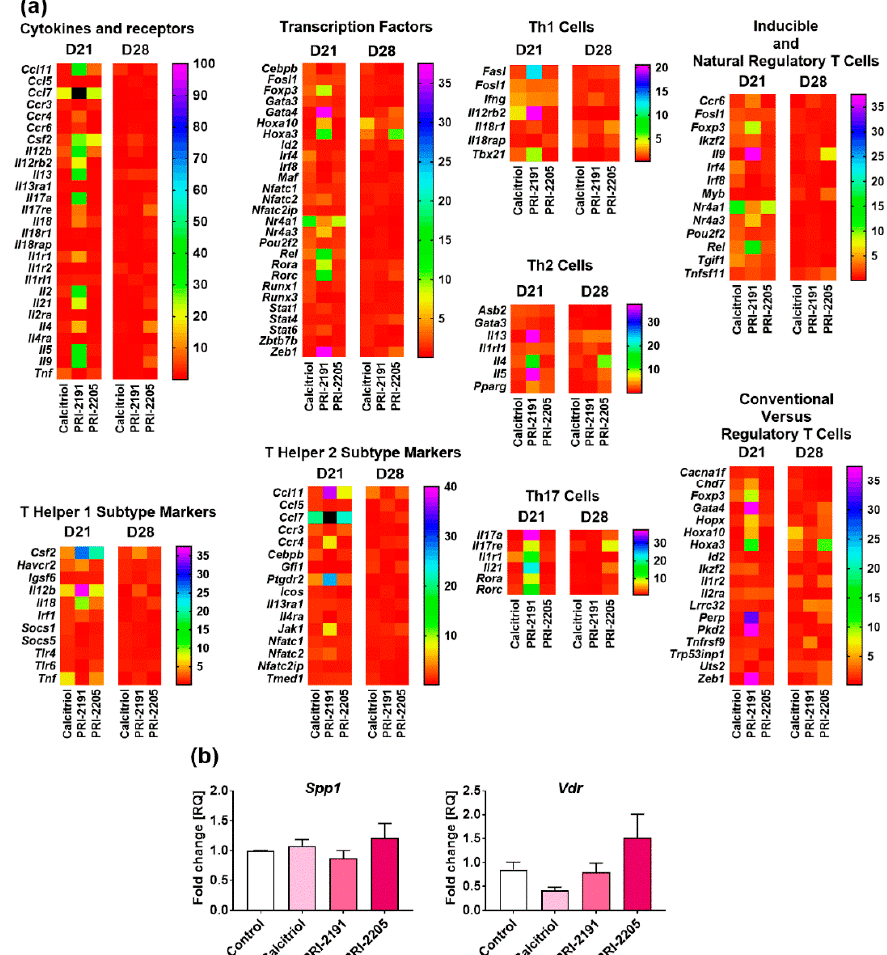
Figure 2. The gene expression profile in isolated mononuclear splenocytes from 4T1 tumor-bearing mice treated with calcitriol and its analogs. ( a ) Heat maps presenting mean relative quantification (RQ) values from duplicates. The genes were grouped according to the analysis provided by manufacturer: cytokines and receptors, transcription factors, T helper lymphocytes (Th1) and Th2 subtype markers, and epigenetically regulated genes: conventional versus regulatory T cells, inducible and natural regulatory T cells, Th1, Th2, and Th17 cells. Values outside the scale are marked in black. Detailed data can be found in the Table S1. Fold-change (RQ) of target cDNA was determined using ∆∆ Ct analysis with reference to beta-actin ( Actb ) and beta-2 microglobulin ( B2m ) and adjusted to the values obtained for the vehicle treated control mice for each treatment group; ( b ) the expression of vitamin D receptor ( Vdr ) and osteopontin ( Spp1 ) mRNA levels (day 28). Fold-change (RQ) of target genes was determined using ΔΔ Ct analysis compared to beta-2 microglobulin ( B2m ) and adjusted to the values obtained for the vehicle treated control mice for each treatment group. Data presentation: mean with standard error of mean. Number of samples analyzed was 2–3 per group. Statistical analysis: Kruskal–Wallis multiple comparison test. * p < 0.05.